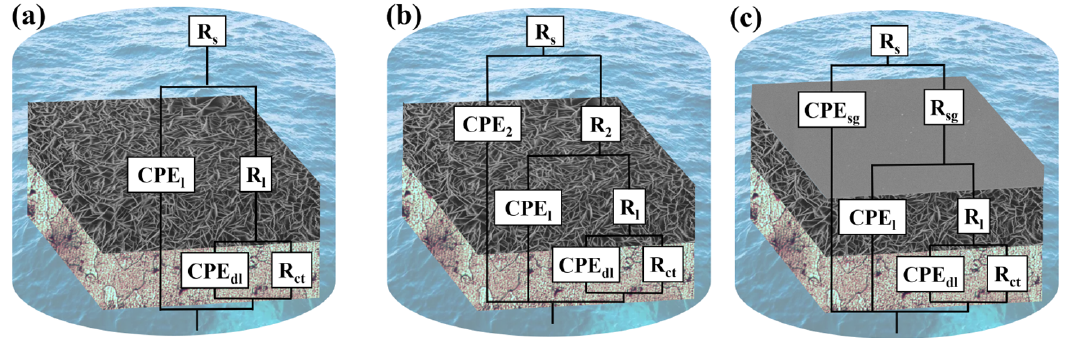
Figure 6. Equivalent circuits employed for fitting the impedance spectra of LDH ‐ N coated system ( a ), LDH ‐ V coated system ( b ) and LDH ‐ V/SG ‐ Ce coated system ( c ).